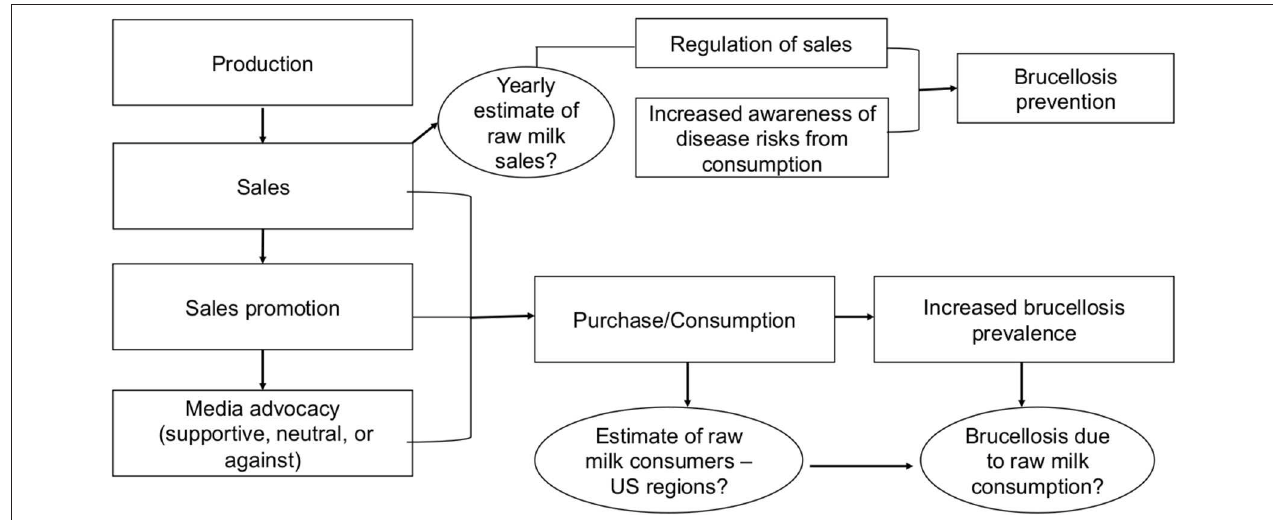
FIGURE 7 | An analytical framework is proposed for understanding the complex factors associated with the increased prevalence of raw milk-acquired brucellosis in the United States. The circles represent priority areas and gaps in evidence that require additional research to facilitate the establishment of the safety and quality control measures for the raw milk sales process, and also design an effective strategy for the prevention of raw milk-acquired